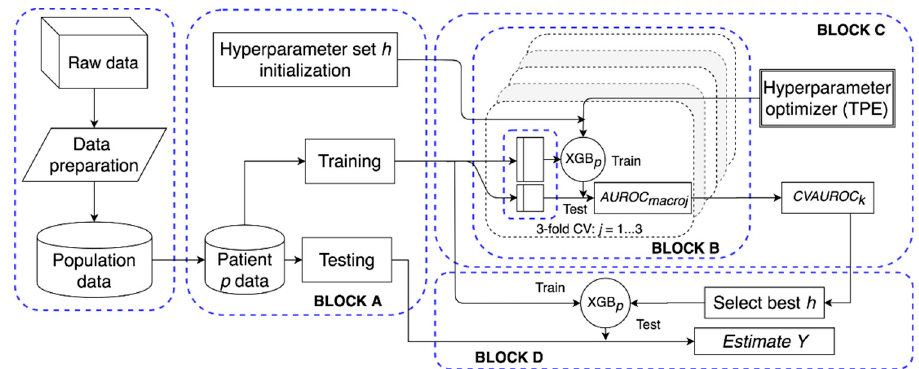
Figure 2. Structure of the proposed extreme gradient-boosted tree (XGB p ) software framework. After data preparation, for patient p , block A initializes h and splits the data in training and test; block B computes the performance of the hyperparameter set in a three-fold cross validation (CV) setting over the training set; block C implements a tree-structured Parzen estimator to optimize h ; block D selects the best h set and evaluates the performance of XGB p on the test set.